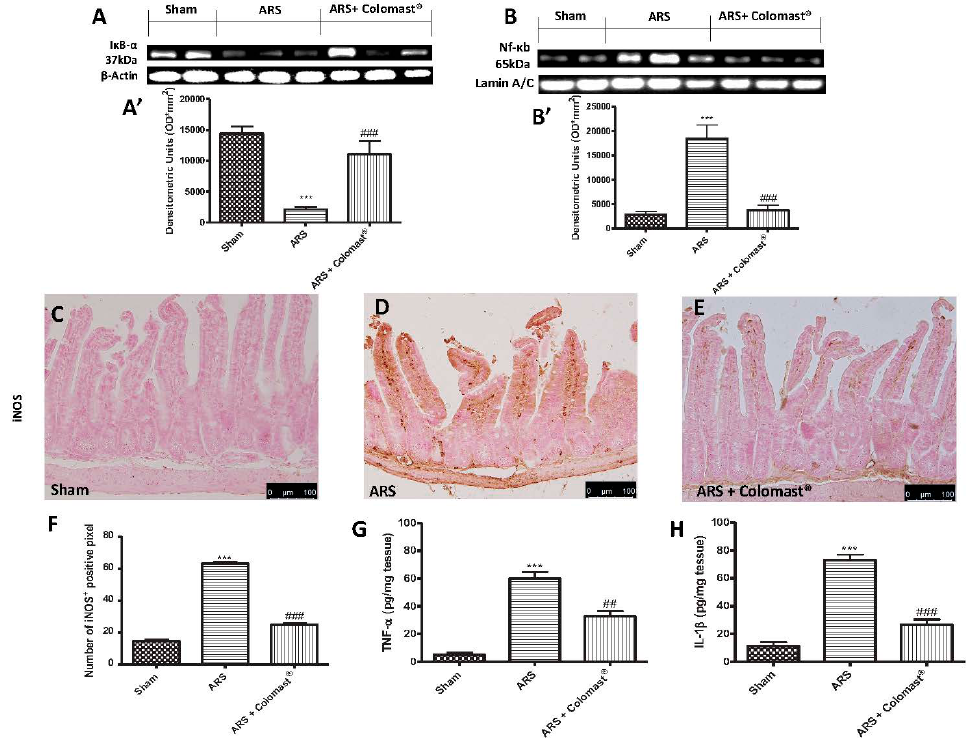
Figure 5. Effect of Colomast ® pre-treatment on inflammation pathway. Western blots and respectively densitometric analysis of IkB- α ( A , A’ ), NF-kB p65 ( B , B’ ). Immunohistochemistry evaluation of iNOS expression on sham ( C ), ARS ( D ), and Colomast ® ( E ); graphical quantification ( F ). Elisa kit of TNF- α ( G ) and IL-1 β ( H ) expressed in ileum tissue. A demonstrative blot of lysates with a densitometric analysis for all animals is showed. Images are figurative of at least three independent experiments. Values shown are means ± SEM of six animals in each group. For the immunohistochemistry, a 20 × magnification is shown (100-µm scale bar). *** p < 0.001 vs. sham; ## p < 0.01 vs. ARS group; ### p < 0.001 vs. ARS group.